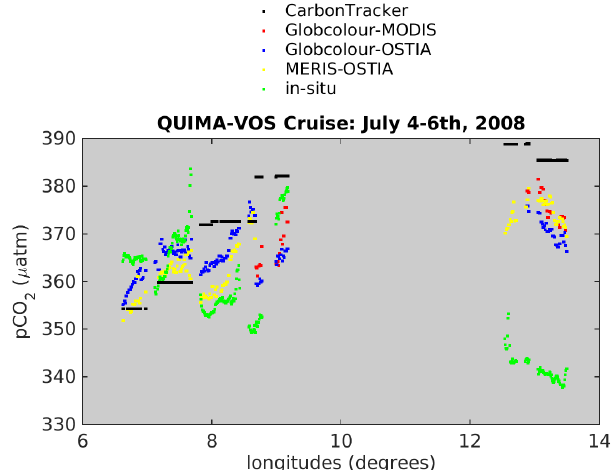
Figure 11. Values of p CO Ctrack SST/GLOBCOLOUR Chl) (red points), p CO infer SST/GLOBCOLOUR Chl) (blue points) p CO infer SST/MERIS Chl) (yellow points) and p CO insitu a function of latitude corresponding to the valid intersections dur- ing the QUIMA cruise through 4–6 July